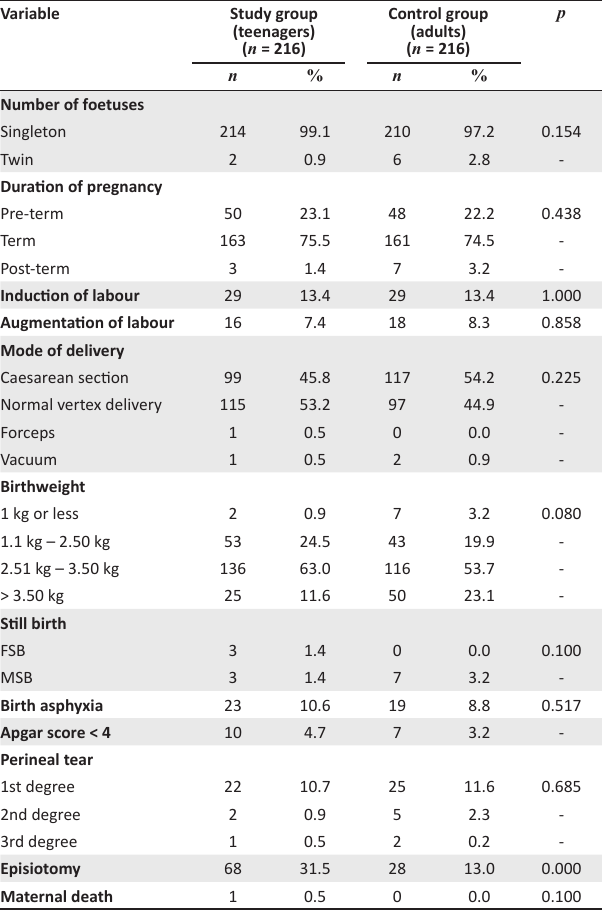
TABLE 3: Outcome of pregnancy. Variable Study group